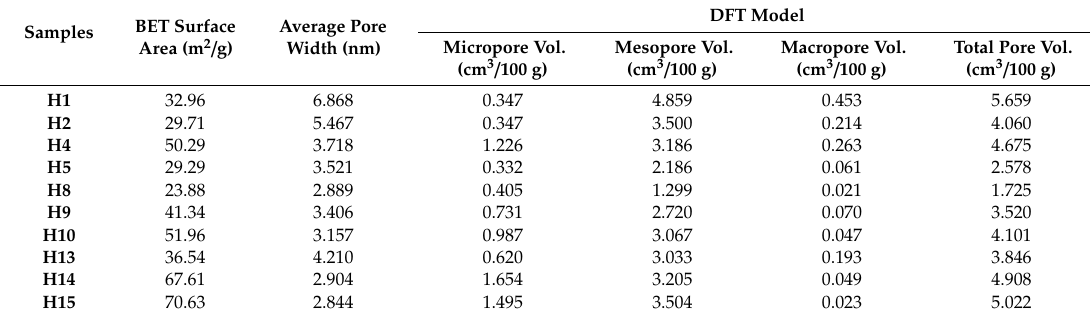
Table 3. Summary of low-pressure nitrogen adsorption results after exposure to scCO 2 . Samples BET Surface Area (m 2 /